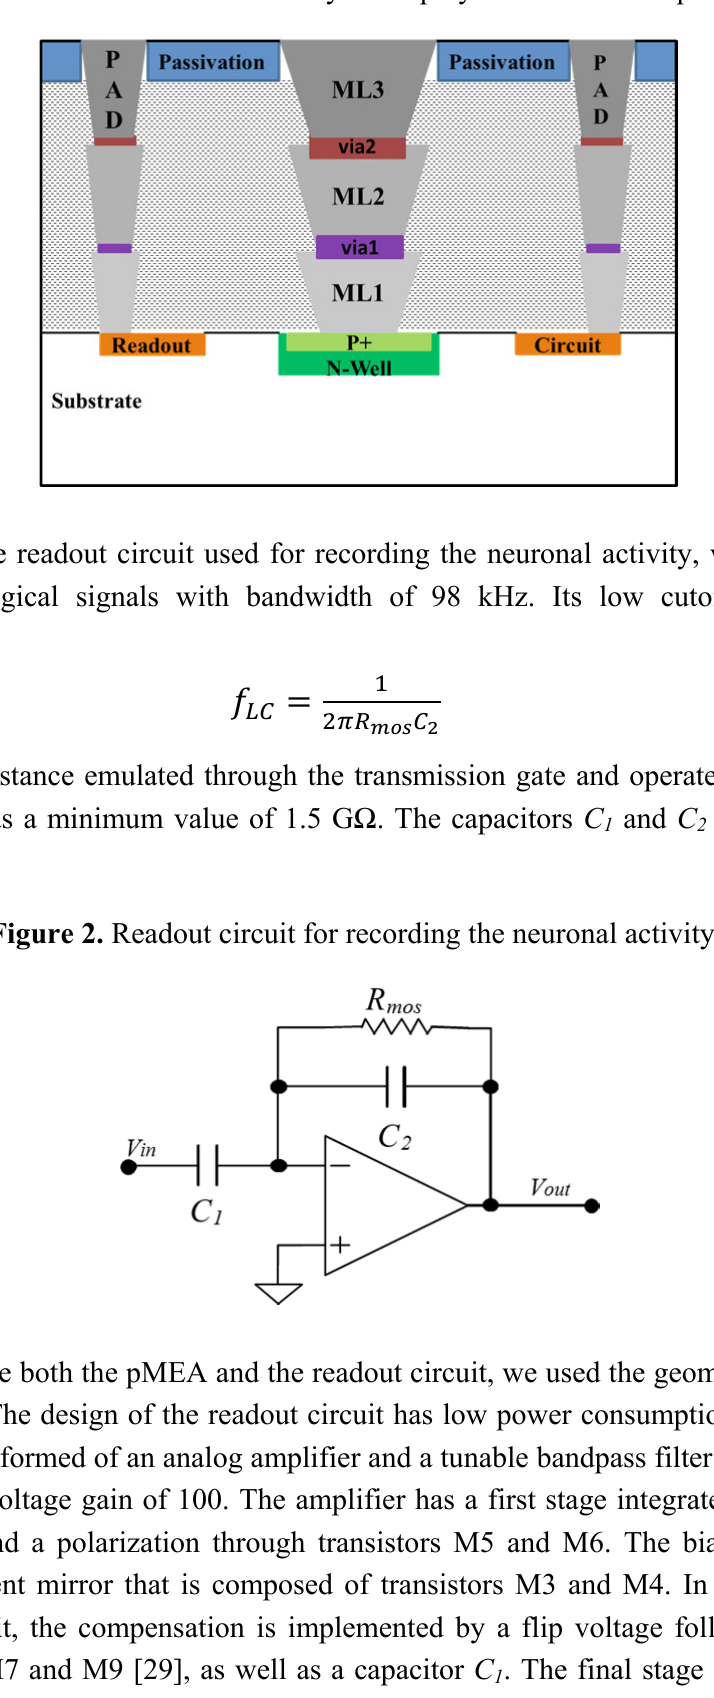
Figure 1. Cross section of the layers employed in the CMOS process.